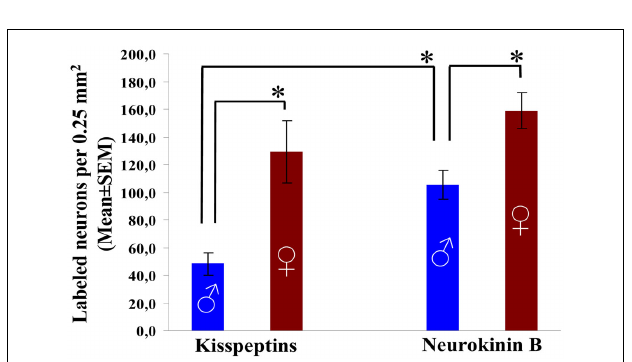
FIGURE 2 | Size of kisspeptin-IR and preproNKB-IR perikarya in the Inf of aged men and women. The mean surface area covered by the silver– gold-intensified Ni-DAB chromogen was used as an index of perikaryon size.The area of immunolabeled cell bodies differs between aged men and women in case of both peptides.The difference likely reflects a robust neuronal hypertrophy in postmenopausal females. ∗ P < 0.05.